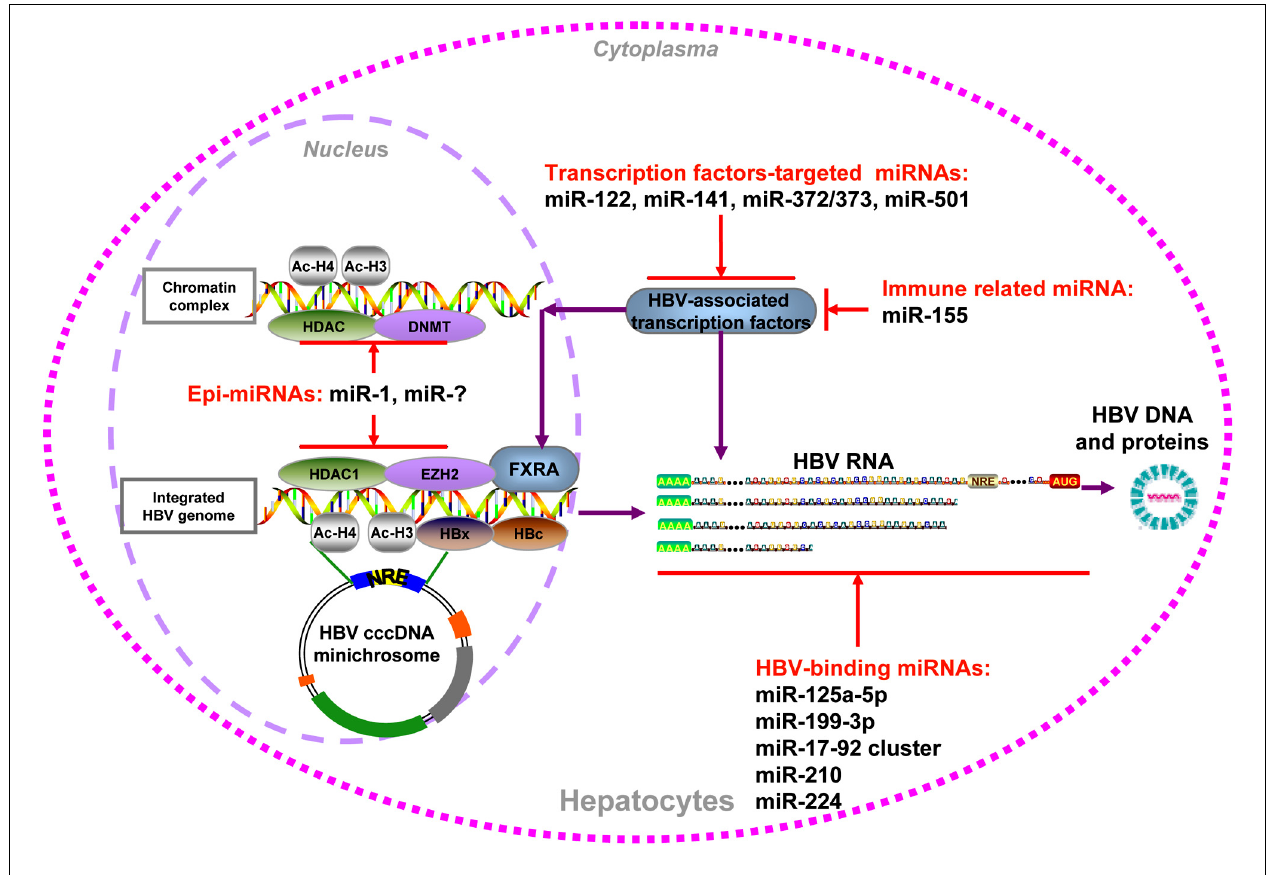
FIGURE 1 | Summary of cellular miRNAs effect on HBV replication. HBV DNA could be integrated into host genome or form cccDNA minichromosome in the hepatocytes nucleus. It serves as the temple for viral transcription, viral